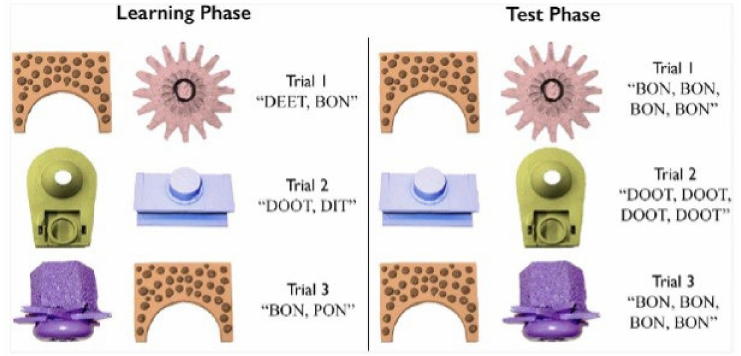
Figure 2. Example of a learning ( left ) and test ( right ) trial (figure from